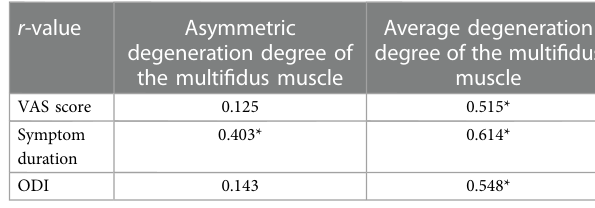
*Signi fi cant if P